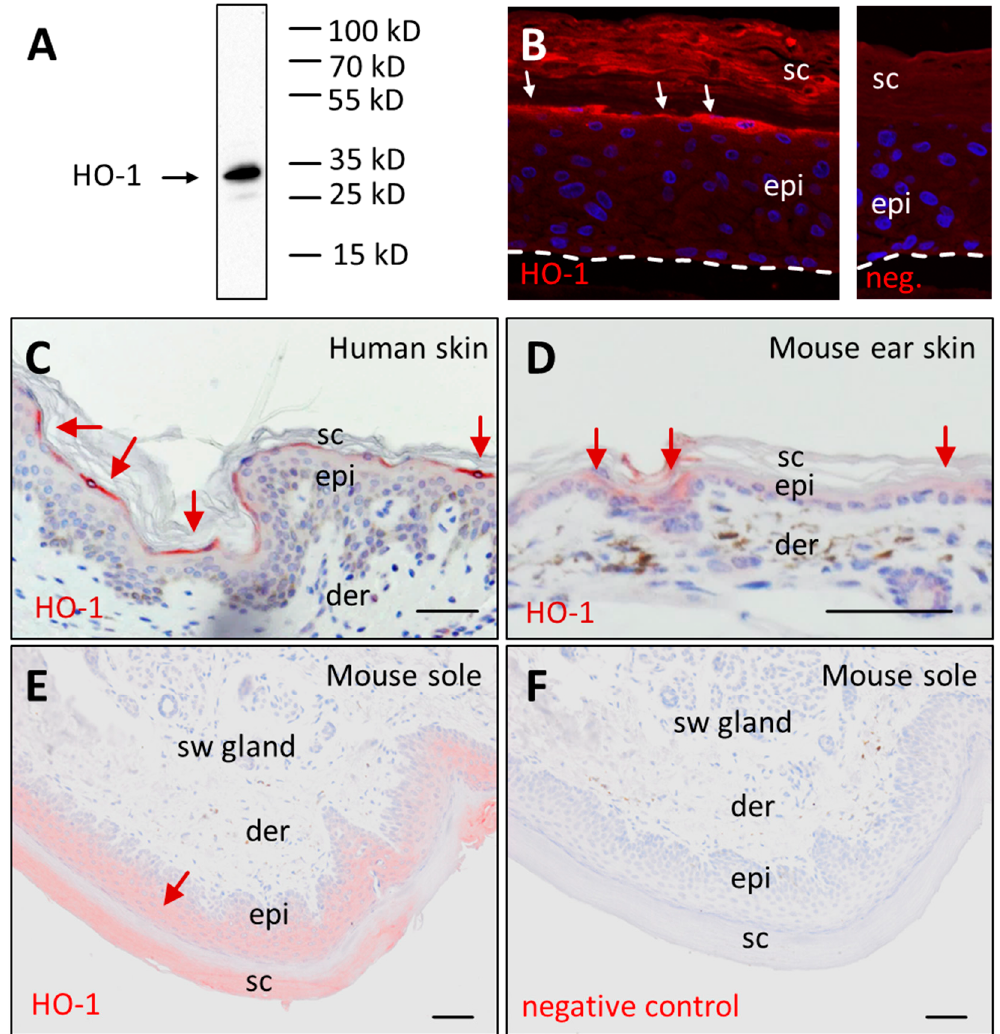
Figure 3. Heme oxygenase-1 (HO-1) protein is present in terminally differentiated keratinocytes. ( A ) The anti-HO-1 antibody was used in Western blot analysis of human keratinocytes differentiated in an in vitro skin equivalent. A band at 33 kilo-Daltons (kD), corresponding to the predicted molecular mass of HO-1, was detected. Positions of a molecular mass marker are indicated on the right. ( B ) Immunofluorescence labeling (red) of HO-1 in human skin equivalents. Immunohistochemical staining (red) of HO-1 in human skin ( C ), mouse ear skin ( D ) and mouse sole skin ( E ). ( F ) Negative control. Sections were counter-stained with the DNA stain Hoechst 33258 (blue) ( B ) and hematoxylin (blue) ( C – F ). Images are representative for n = 3 biological replicates. Scale bars, 50 µm. der, dermis; epi, epidermis; neg., negative control; sc, stratum corneum; sw, sweat.